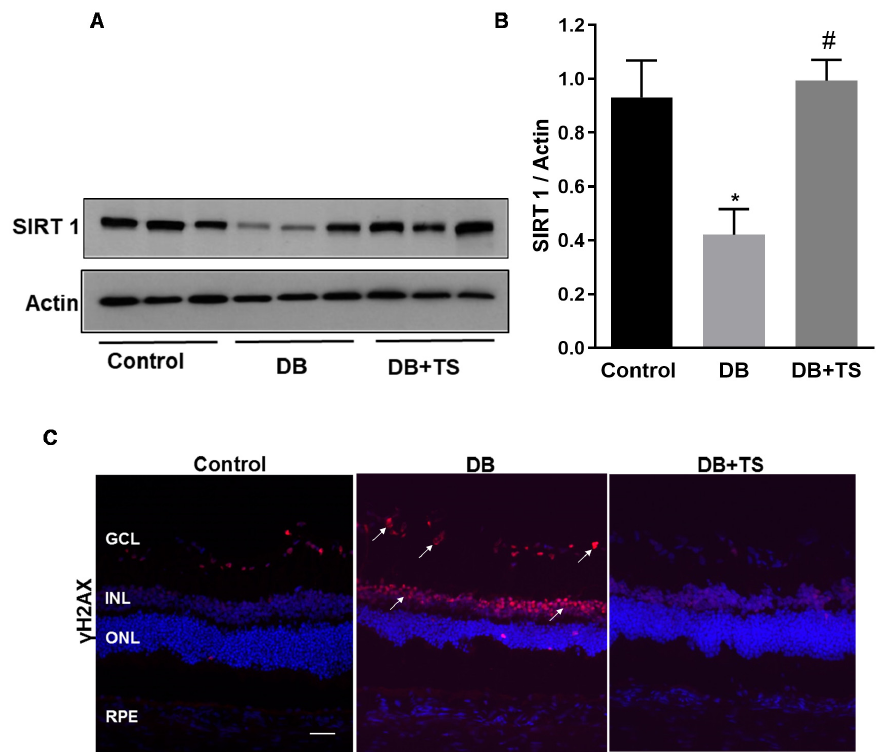
Figure 4. E ff ects of Tubastatin A on senescence in diabetic retina. ( A ) Immunoblot showing protein expression levels of SIRT1 measured in retinal extracts of STZ-rats (DB), STZ-rats receiving TS (10 mg / kg) (DB + TS) and age-matched normoglycemic control rats. ( B ) Bar histograms representing densitometric quantification of SIRT1 immunoblotting normalized to the loading control actin. ( C ) Representative images of immunohistochemical analysis of γ H2AX (red) in retinas of STZ-rats (DB), STZ-rats treated with TS (DB + TS) and age-matched normoglycemic control rats (control). Nuclei were stained with DAPI. Scale bar, 50 µ m. Values are mean ± SEM for n = 6. * p < 0.05 vs. control and # p < 0.01 vs.